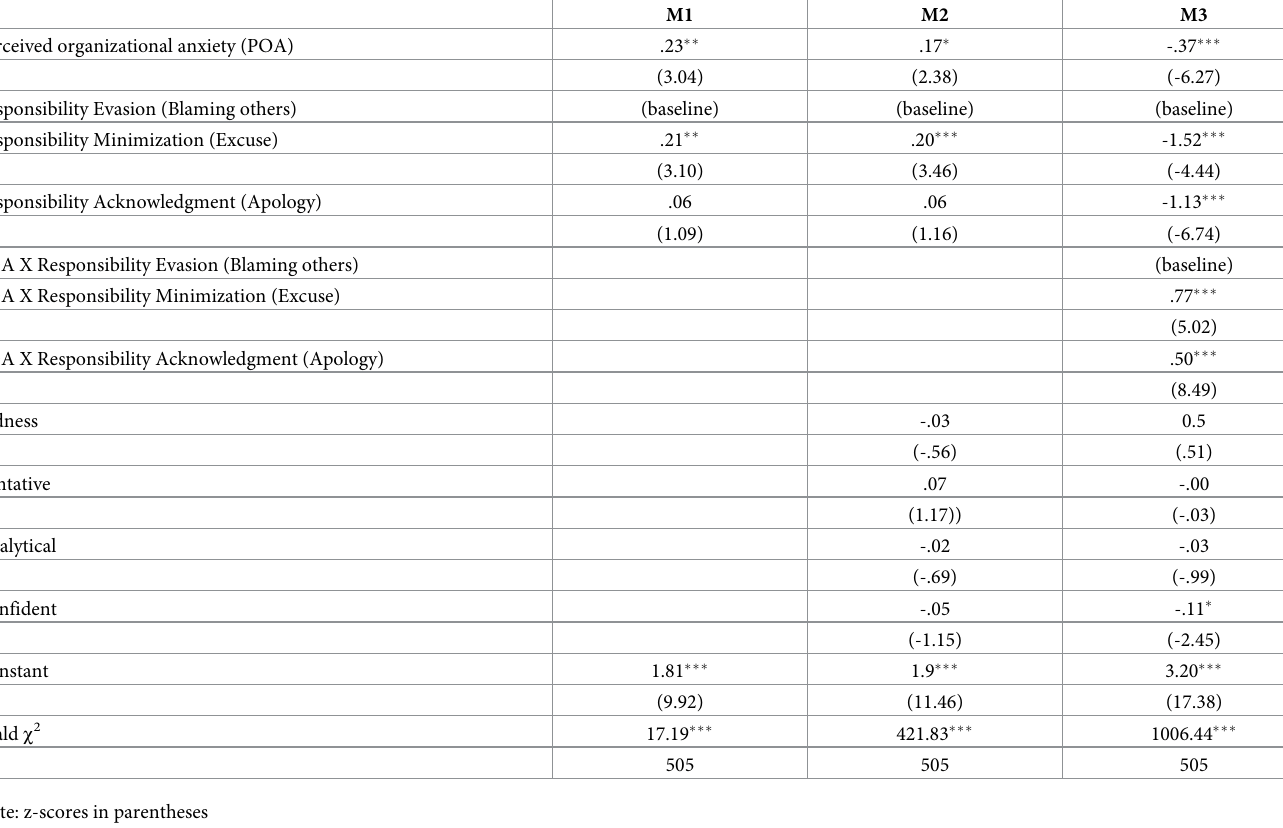
Table 2. Interaction of perceived organizational anxiety and crisis response strategy on public